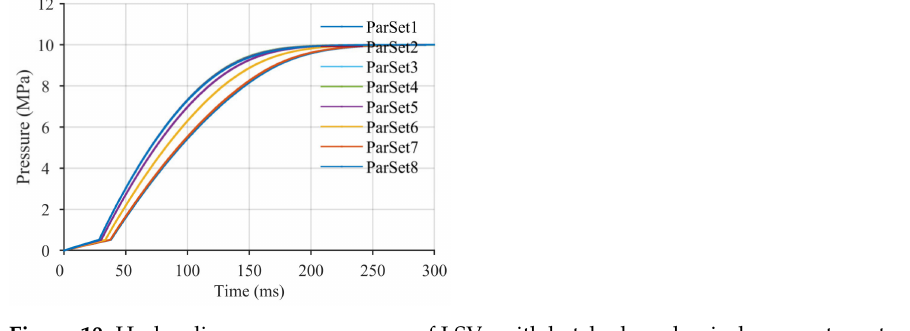
Figure 10. Hydraulic pressure responses of LSVs with batched mechanical parameter sets. Table 4. Batched mechanical parameter sets for LSVs. Three core parameters: diameter of valve ball, seat semi-angle of valve, and equivalent current signal of